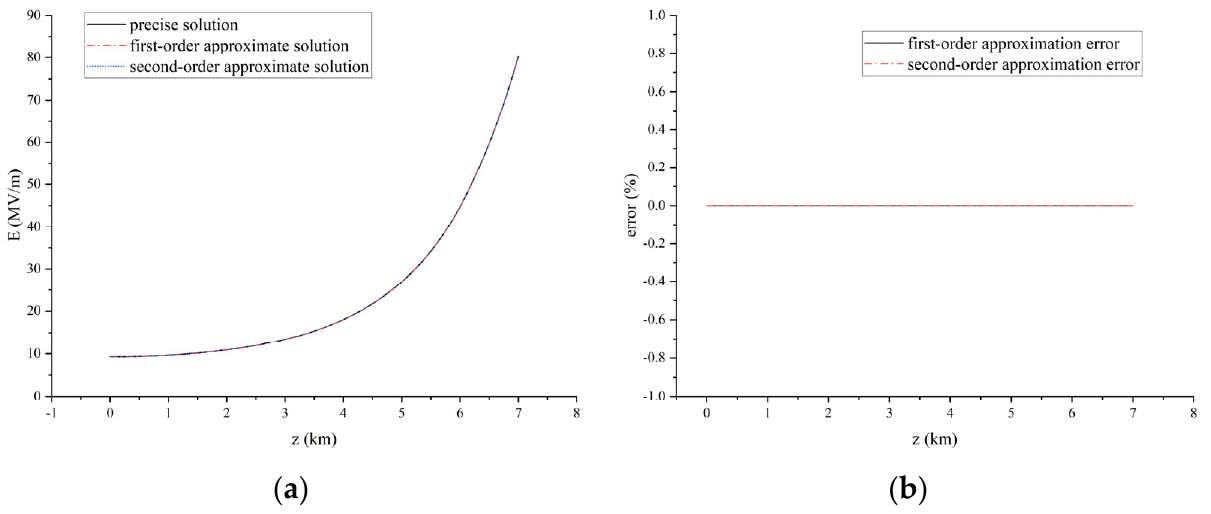
Figure 4. ( a ) Comparison of the first-order approximate solution, second-order approximate solution and exact solution while r = 0. ( b ) Relative error of first-order approximation and second-order approximation while r = 0.